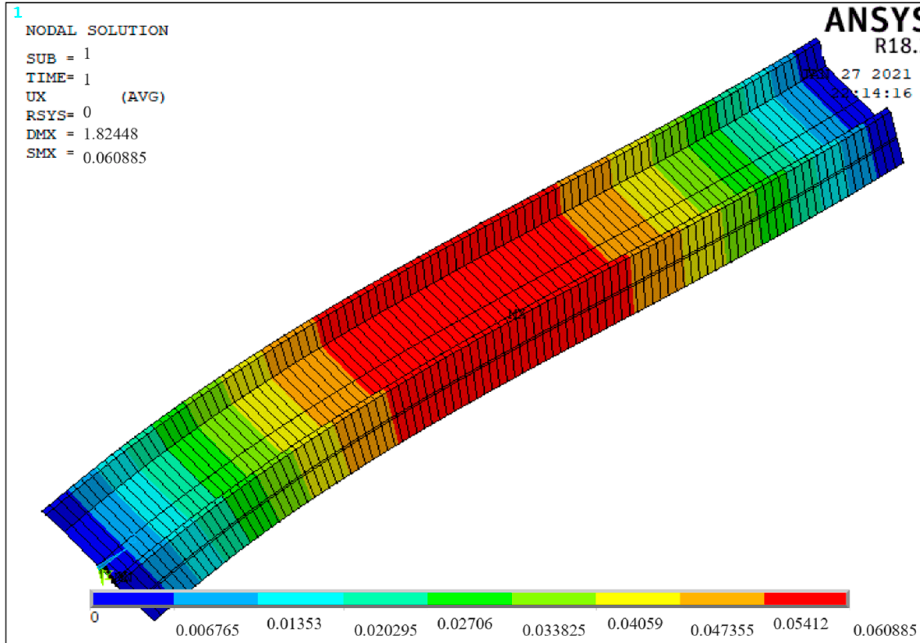
Figure 11. X-direction displacement diagram of the rod of the derrick leg.